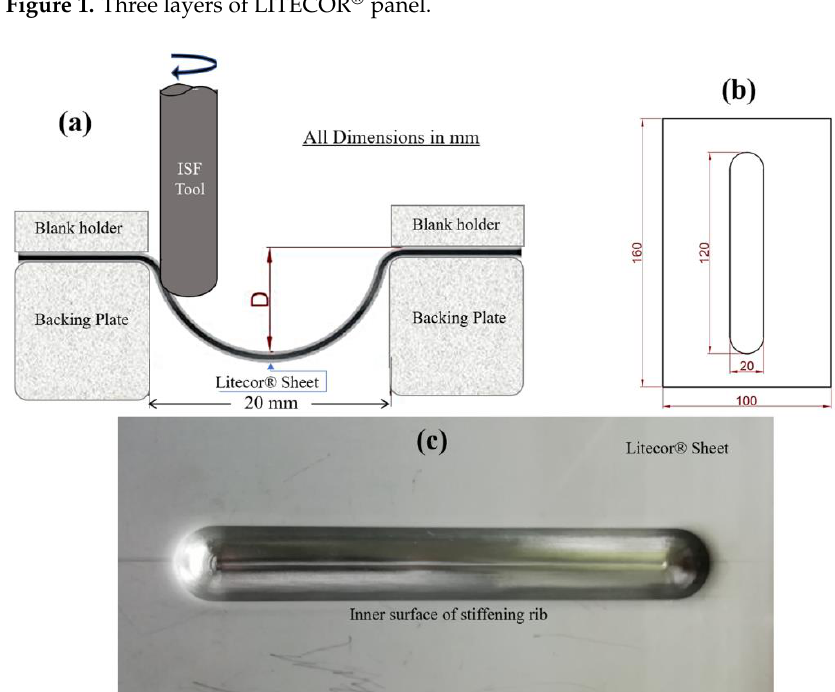
Figure 2. ( a ) SPIF tool scheme, ( b ) sample dimensions, and ( c ) stiffening rib in LITECOR ® .